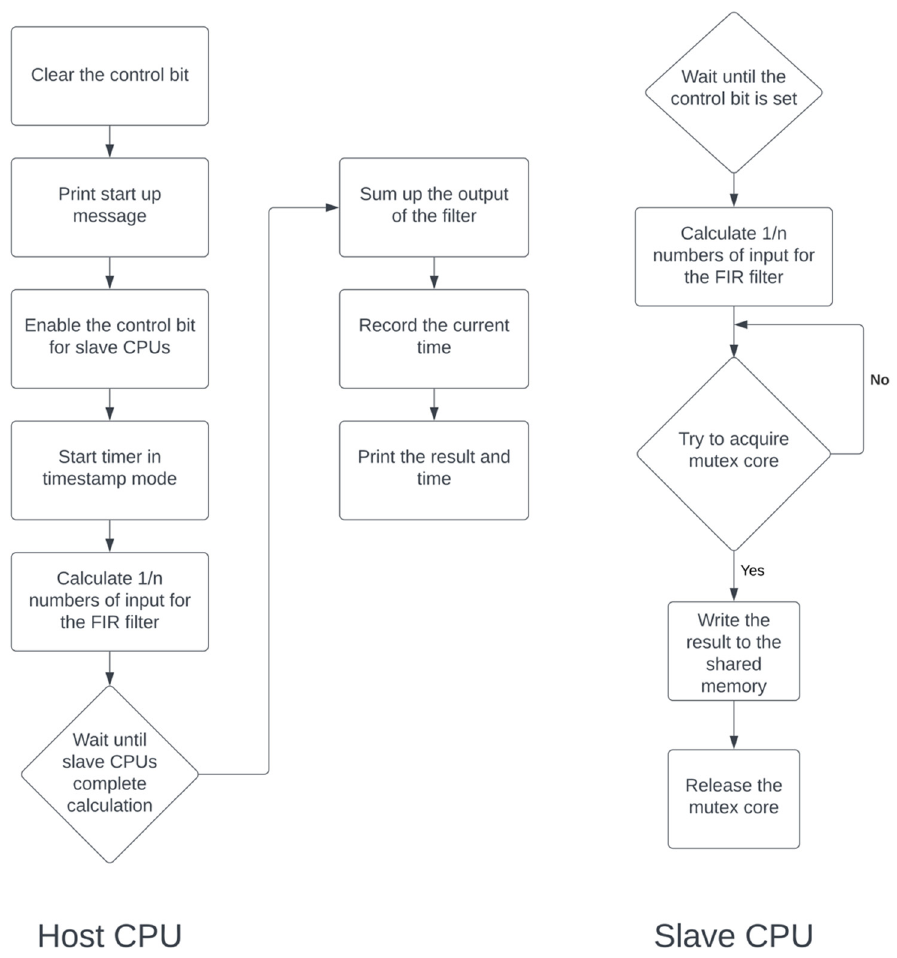
Figure 16. The mechanism of memory assignment.